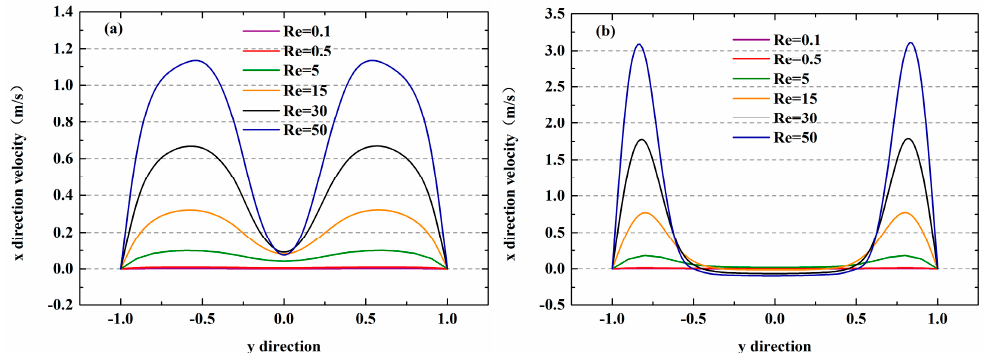
Figure 21. The velocity variation in the x-direction at 50 μ m downstream of the obstacle under different Re values: ( a ) Ω = 0.1; ( b ) Ω = 0.7.